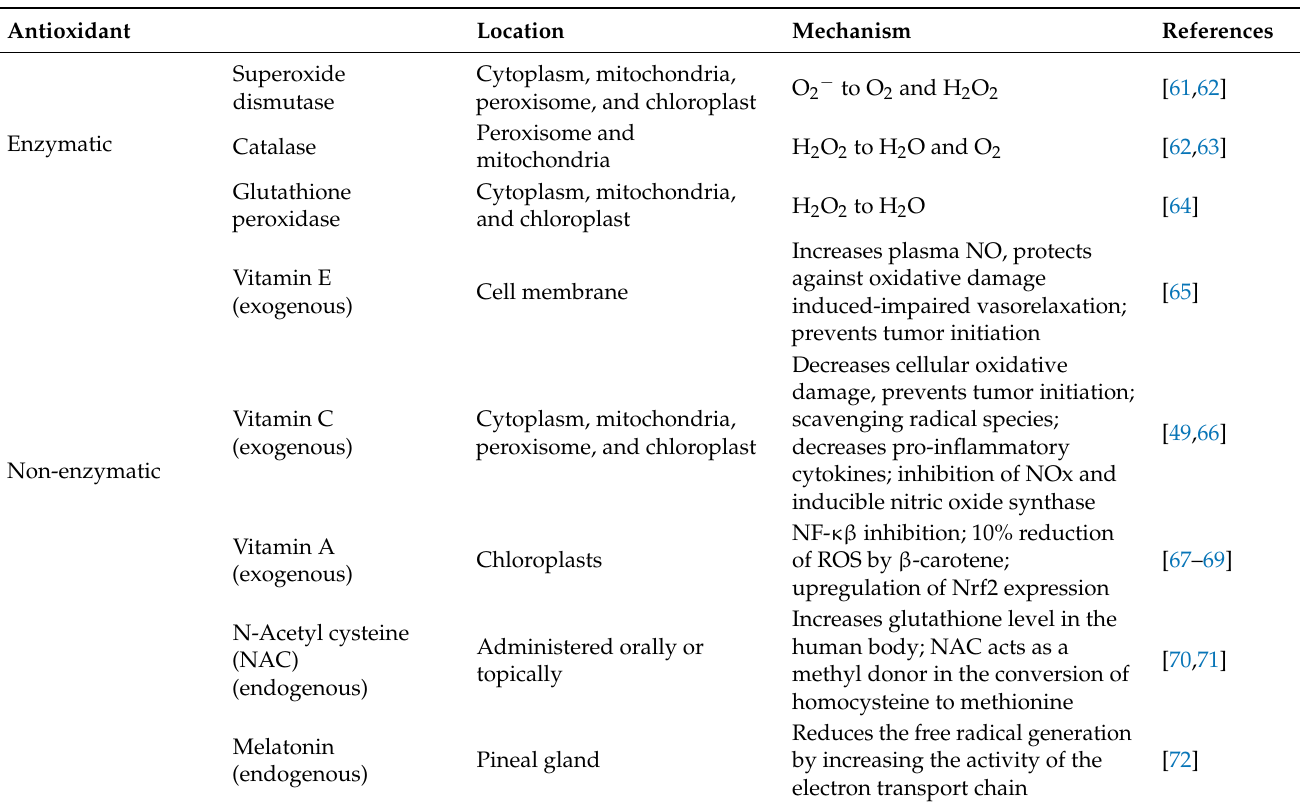
Table 2. List of antioxidants involved in